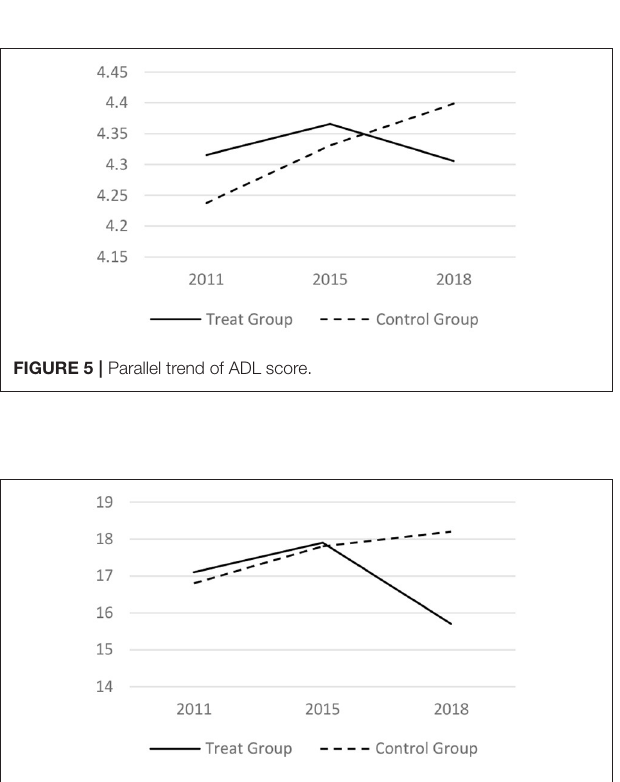
FIGURE 6 | Parallel trend of mental health